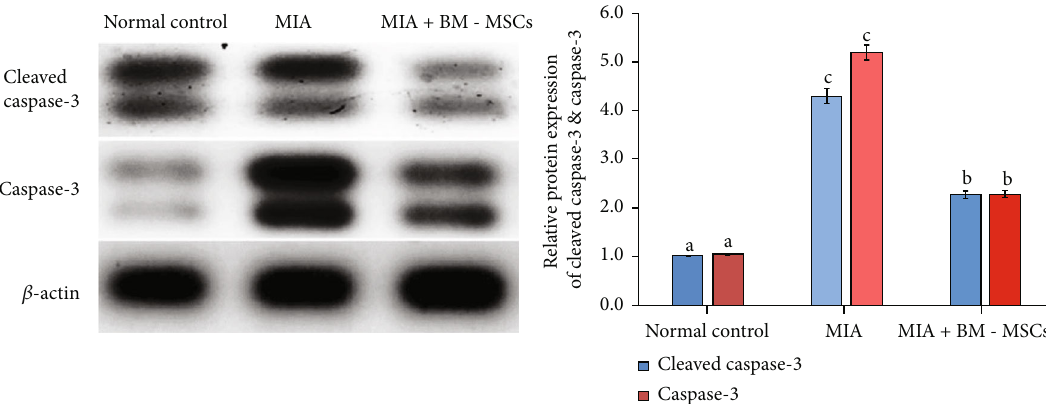
Figure 8: E ff ect of BM-MSC treatment ( 5 × 10 6 cells/rat) on the protein levels of cleaved caspase-3 and caspase-3 in MIA-induced animals. Means, which have di ff erent symbols, are signi fi cantly di ff erent at P < 0 : 05